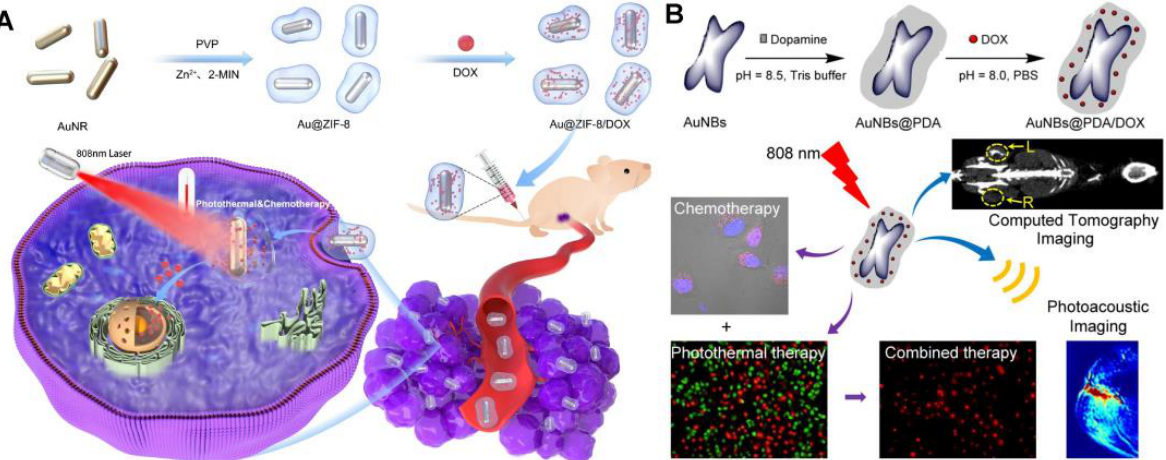
Figure 2. Preparation of high drug-loading nanomedicines from gold-based nanomaterials for combined chemotherapy-photothermal treatment of tumors. ( A ) The schematic illustration of the synthetic procedure of Au@ZIF-8/DOX nanocomplexes for the chemo – photothermal synergistic tumor therapy in vivo [60]. ( B ) The diagram of the AuNBs@PDA/DOX nanomedicines preparation and the nanomedicines used for PA/CT imaging-guided chemo – photothermal therapy of tumor [23]. Reprinted with permission from Ref. [23]. Copyright 2021, Elsevier.